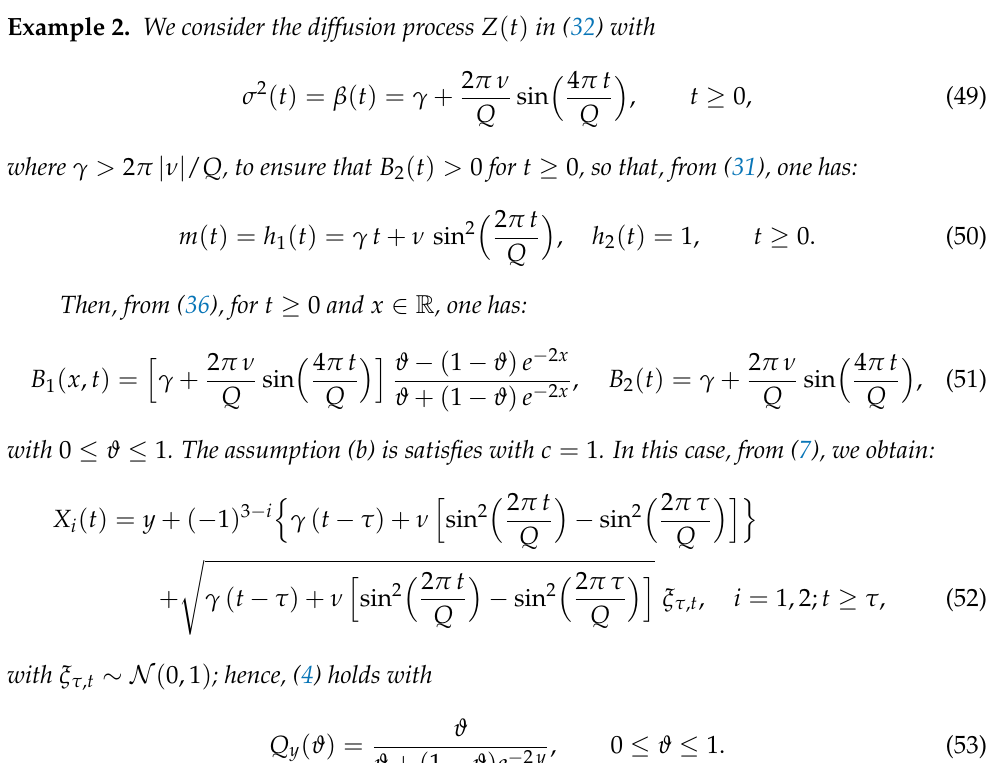
Figure 3. Histograms of FPT through the boundary S for the process Z ( t ) , given in (43), with ϑ = 1, γ = 1.5, ν = 0.1, σ 2 = 2, Q = 1, are compared with the FPT densities (solid curve) of the Wiener process (cid:101) Z ( t ) with drift µ = 1.5 and infinitesimal variance σ 2 = 2 from (cid:101) Z ( 0 ) = 0 through S